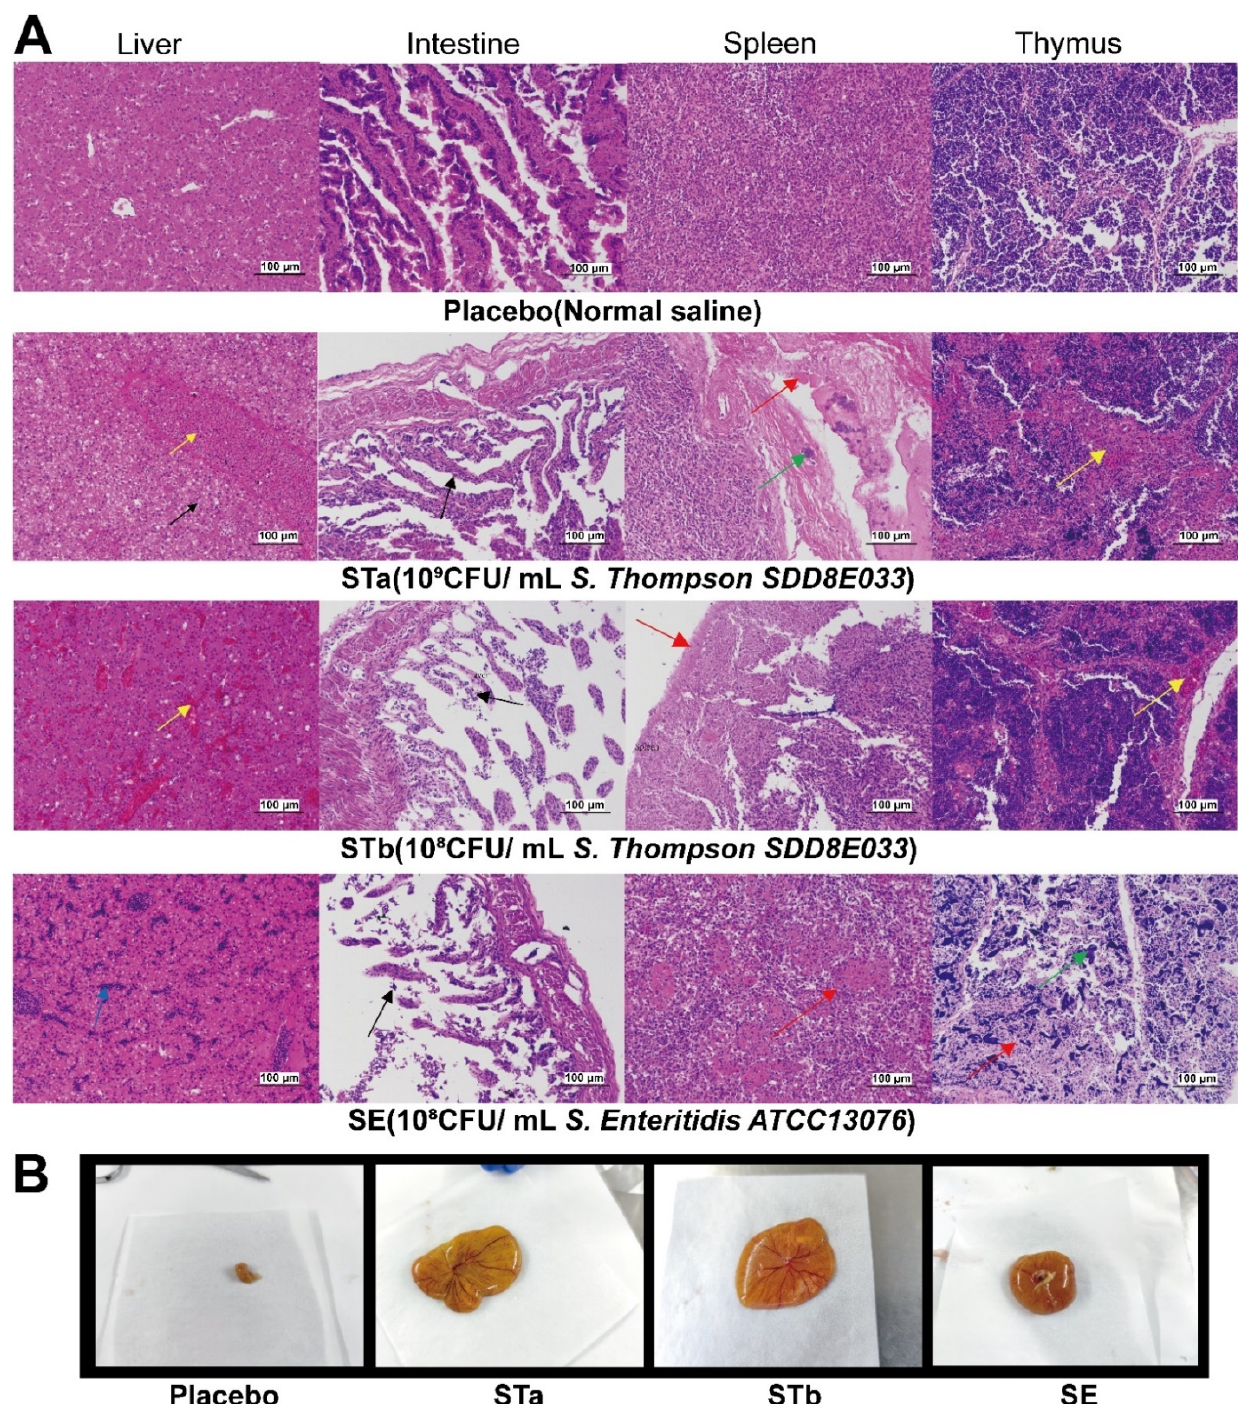
Figure 5. Pathological changes of the main organs and autopsy of yolk sacs following experimental inoculation. ( A ) Yellow arrow: stasis, black arrow: vesicular degeneration of hepatocytes or sloughing of intestinal epithelial cells, blue arrow: infiltration of inflammatory cells, red arrow: cytoplasmic shrinkage or nuclear pyknosis, green arrow: calcified nodules. ( B ) The yolk sacs of each group were placed on a weighing paper with a side length of 8.9 cm. Compared to the placebo group, the yolk sacs in the STa, STb, and SE groups showed incomplete absorption, vascular congestion on the sac membrane, liquefied necrosis of the contents, and reduced viscosity of the yolk fluid.